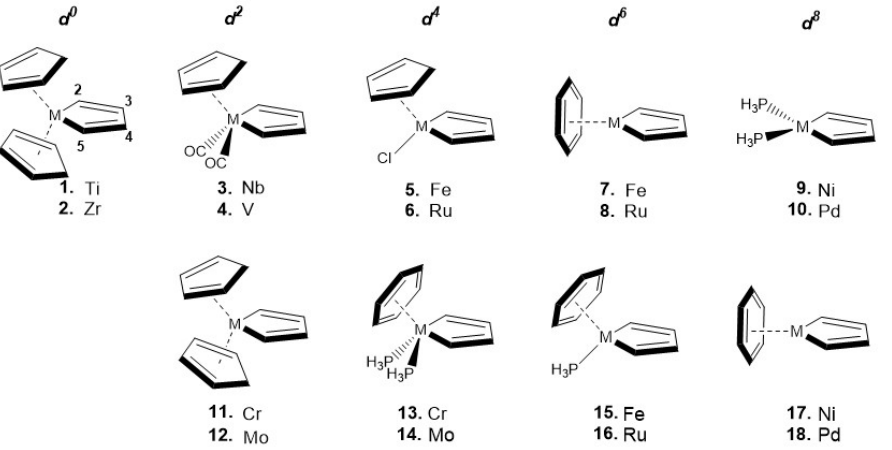
Scheme 1. Structures of the studied